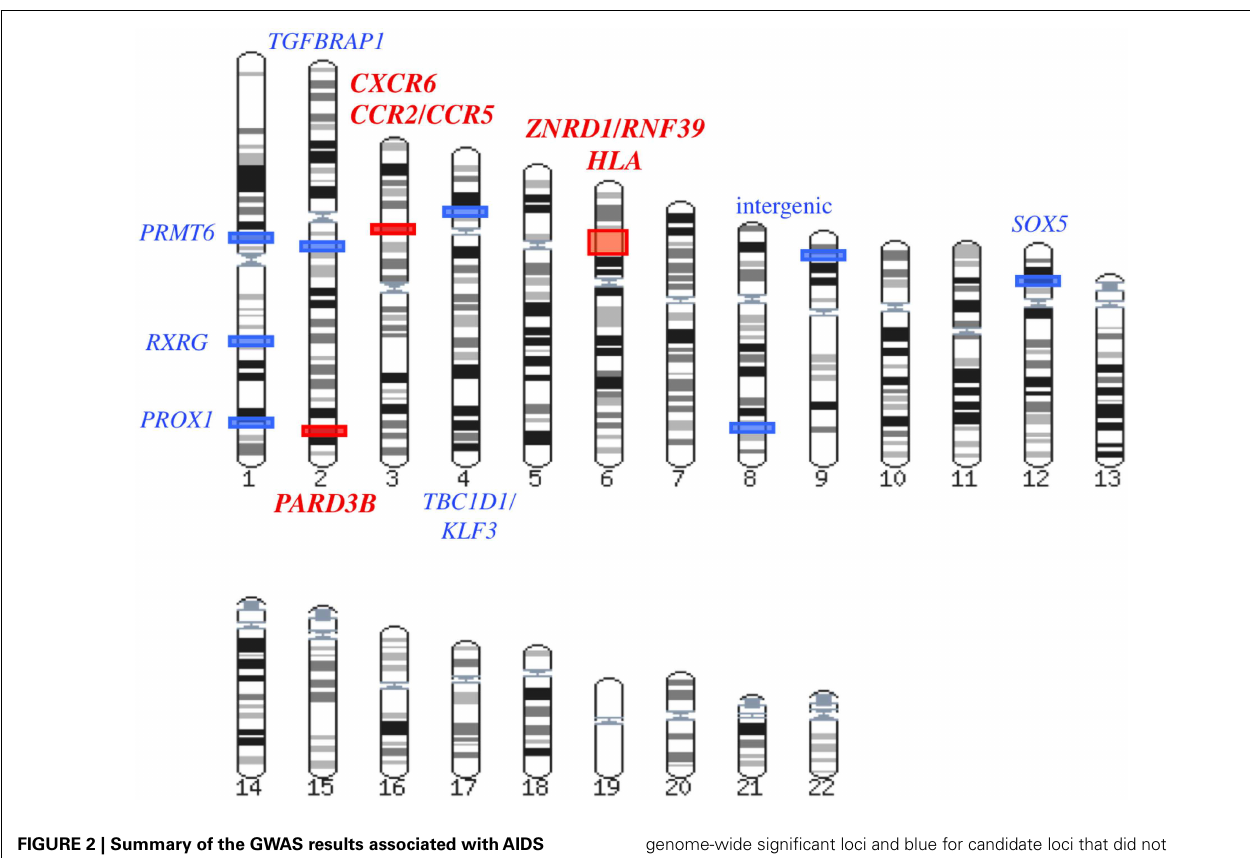
FIGURE 2 | Summary of the GWAS results associated withAIDS progression and/or viral load control . In this karyotype, the statistical significance of the GWAS hits is color-coded: red for